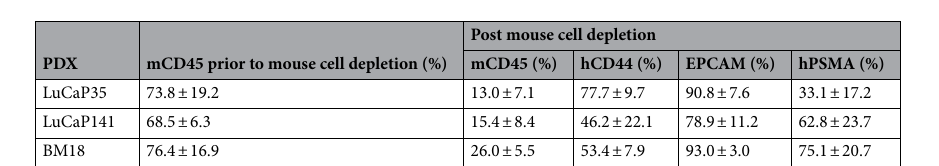
Figure 2. Comparison of vascularisation through a 36 µm or 100 µm mesh. Representative images of vascularisation of BMSC microtissues through the ( a ) 100 µm mesh and through the ( b ) 36 µm mesh (scale bars = 200 µm). Vascular network diameter characteristics for vessels observed feeding microtissues in Microwell-mesh with ( c ) 36 µm mesh size openings (n = 35) and ( d ) 100 µm mesh size openings (n = 35). Grey bars represent blood vessels < 35 µm in diameter and black bars represent blood vessels > 35 µm. Smaller mesh openings would have excluded penetration of the many vessels having diameters greater than > 35 µm, while larger mesh sizes would have theoretically enabled vessels up to 100 µm to pass through. Data was collected from images of Microwell-mesh inserts that had been implanted into animals, harvested, imaged, and then analysed manually using ImageJ.